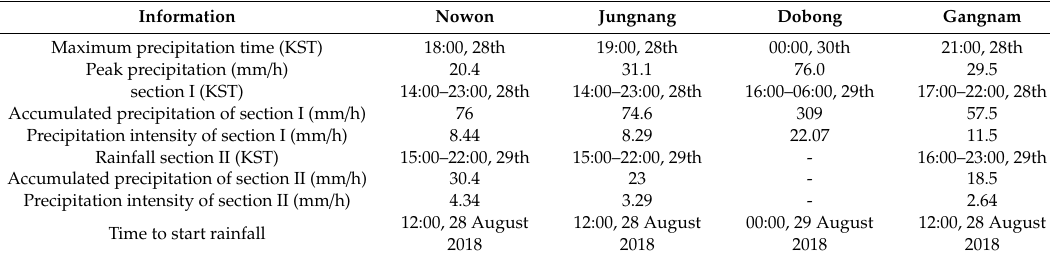
Table 4. Rainfall information of four sites used for the validation of Case 1.